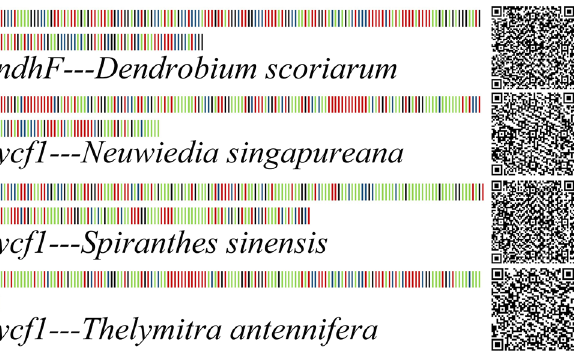
Figure 10. DNA barcodes and two-dimensional DNA barcodes of Orchidaceae species based on ndhF and ycf1 genes. Base A in green, base T in red, base C in blue, and base G in